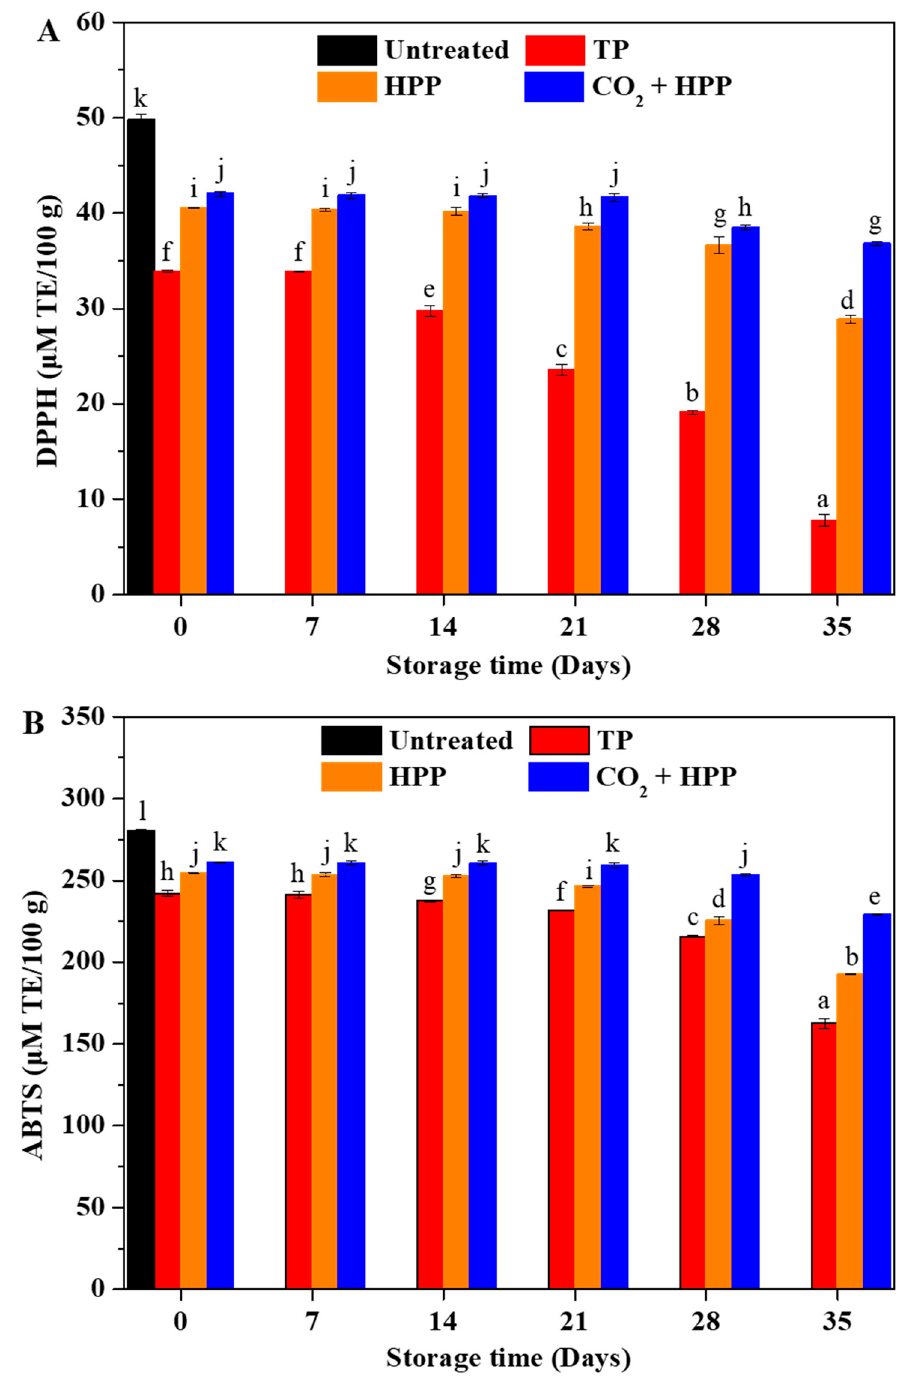
Figure 5. Analysis of DPPH antioxidant capacity ( A ) and ABTS antioxidant capacity ( B ) of TP- (95 °C, 60 min), HPP- (600 Mpa), and (CO 2 + HPP)-treated DFP (600 Mpa) during storage. Different letters (a, b, c, etc.) indicate significantly different means at p < 0.05 (analysis of variance